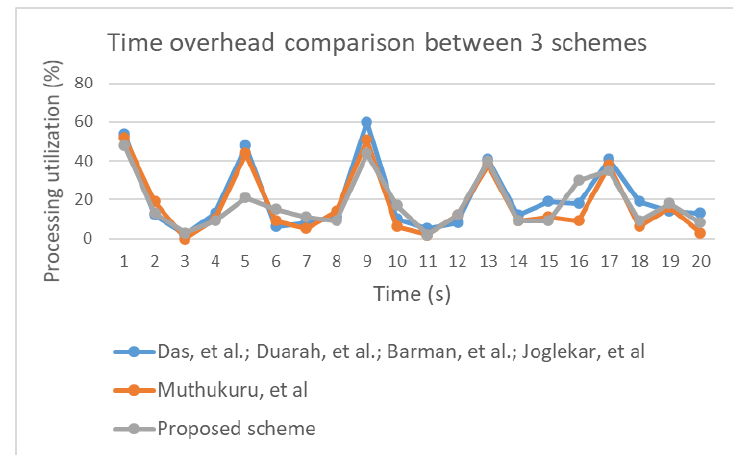
Figure 34. Comparison of time overhead between the proposed scheme and other